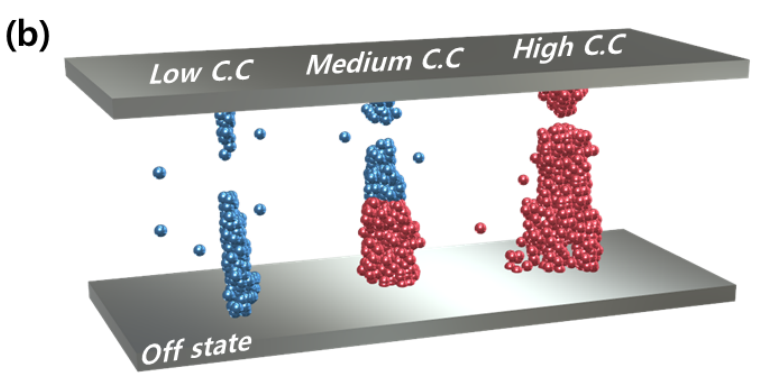
Figure 3. Operation schematics of ( a ) on and ( b ) off state at low, medium, and high current compliance. The thick and stable filament is represented as a red filament, while the thin and unstable filament is illustrated as a blue filament. At medium current compliance, both filaments coexist, which leads to the 1S1M characteristic. The unstable filament exhibits spontaneous rupture, which is illustrated by red arrows.